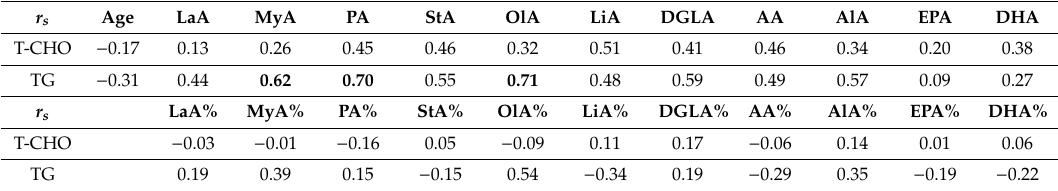
Table 2. Spearman correlation coe ffi cients. Correlation coe ffi cients between T-CHO, TG, age at ICH onset, and FA concentrations and proportions.